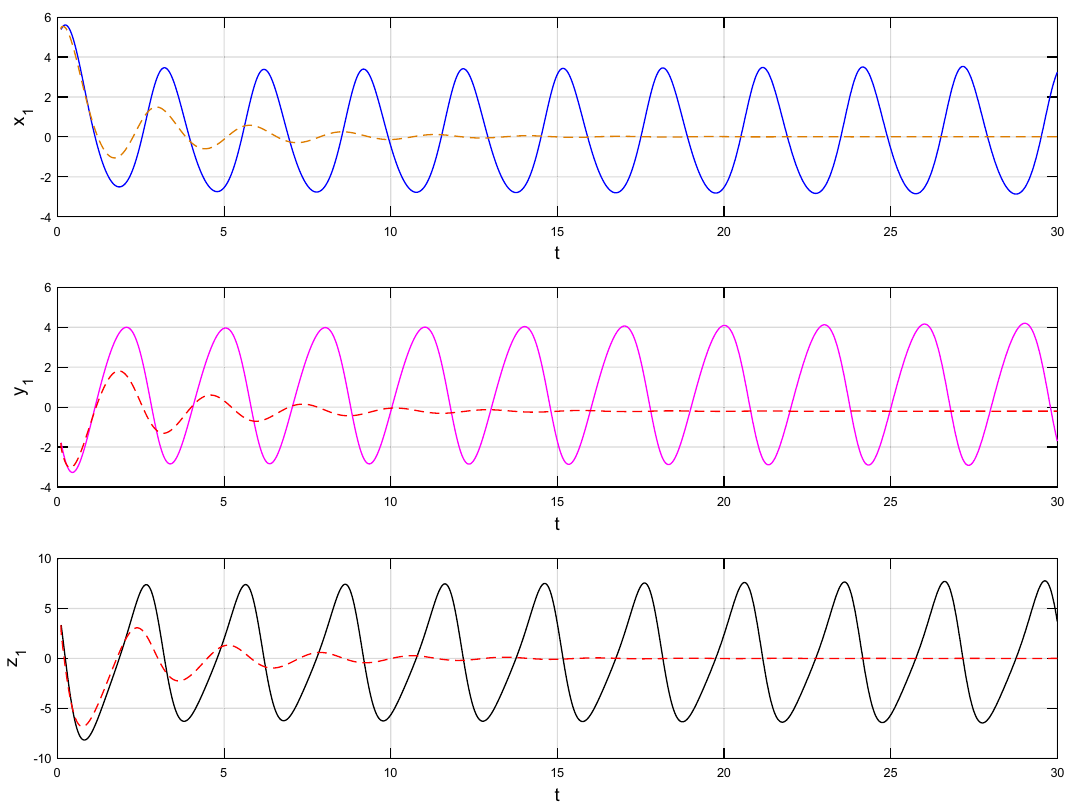
Figure 7. An analysis of the chaotic attractors for this case when α = 1 (line) and α = 0.85